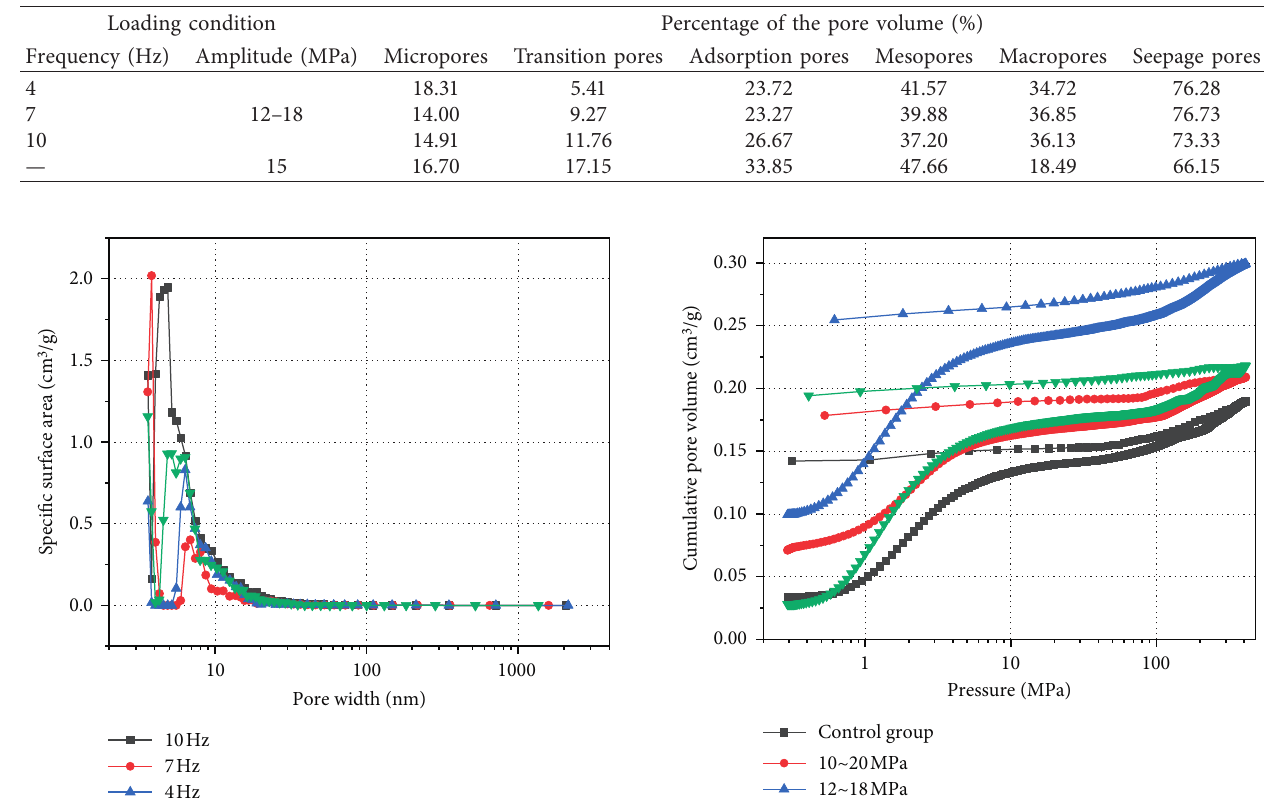
Figure 6: Distribution of the porosities contributed by adsorption and seepage pores at different loading frequencies. Table 3: Percentages of the pore volume at different loading frequencies.